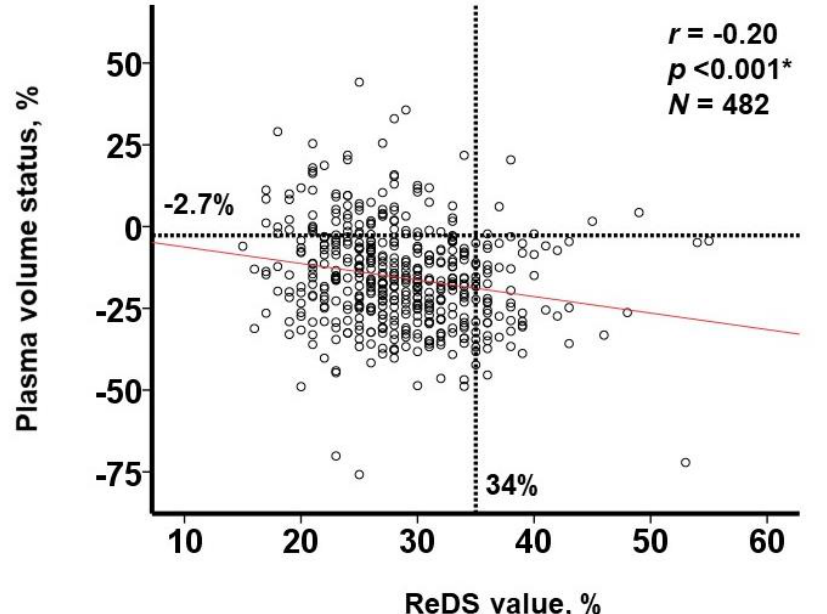
Figure 2. Correlation between ReDS value and PVS. Cutoffs for ReDS value and PVS were defined at 34% and −2.7%, respectively. * p < 0.05 by Pearson’s correlation.